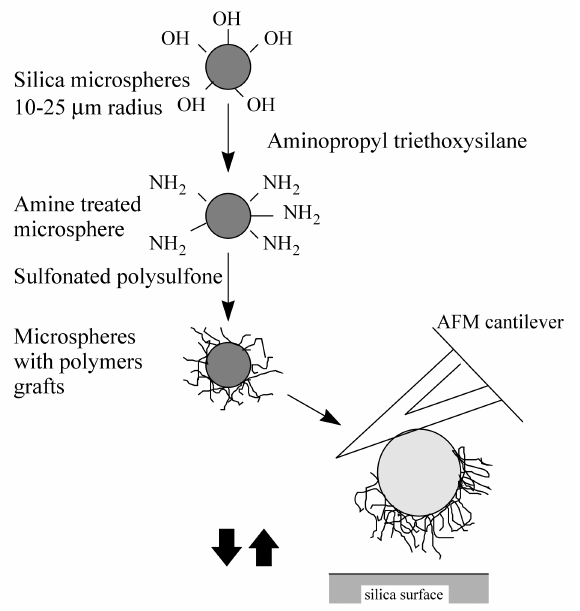
Figure 6. AFM tip preparation and